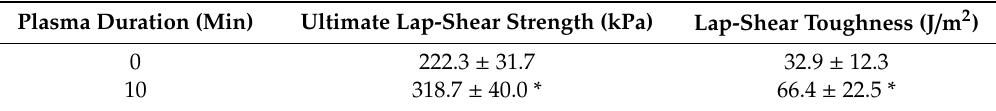
Table 3. E ff ect of plasma treatment on pCD coating adherence to PP substrates. Table 3. Effect of plasma treatment on pCD coating adherence to PP substrates.